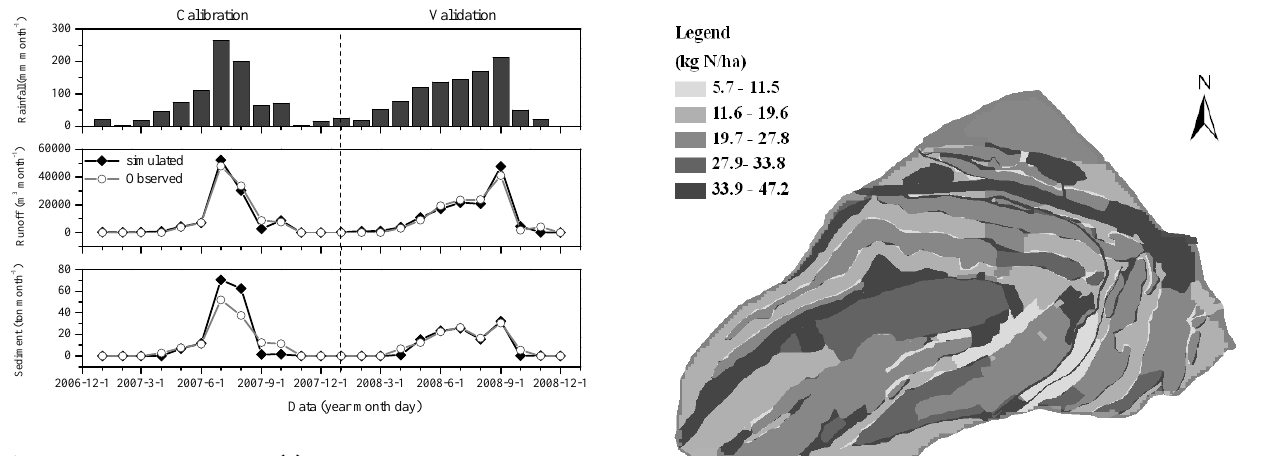
Fig. 2. Monthly precipitation (a) , simulated and measured runoff (the sum of surface runoff and subsurface drainage flow) (b) , and sediment yields (c) for the calibration (2007) and validation (2008) years.